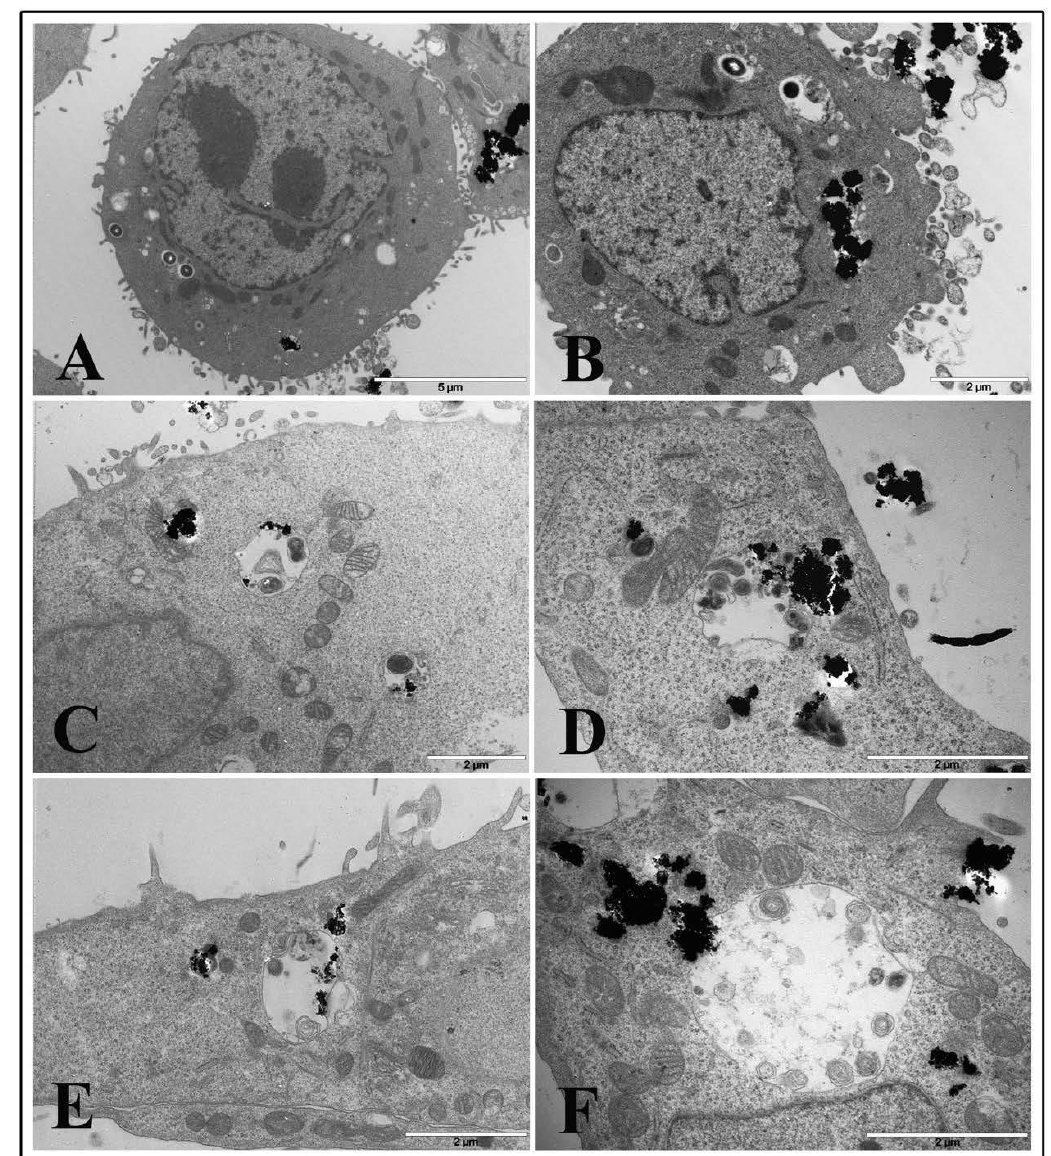
Figure 9. Transmission electron microscopy micrographs of HT-29 cells following exposure to 20 μ g/cm 2 TiO 2 NPs and infected with L. monocytogenes . Representative images of TiO 2 NP pre-treated cells at 2 h ( A , B ) and 6 h ( C – F ).